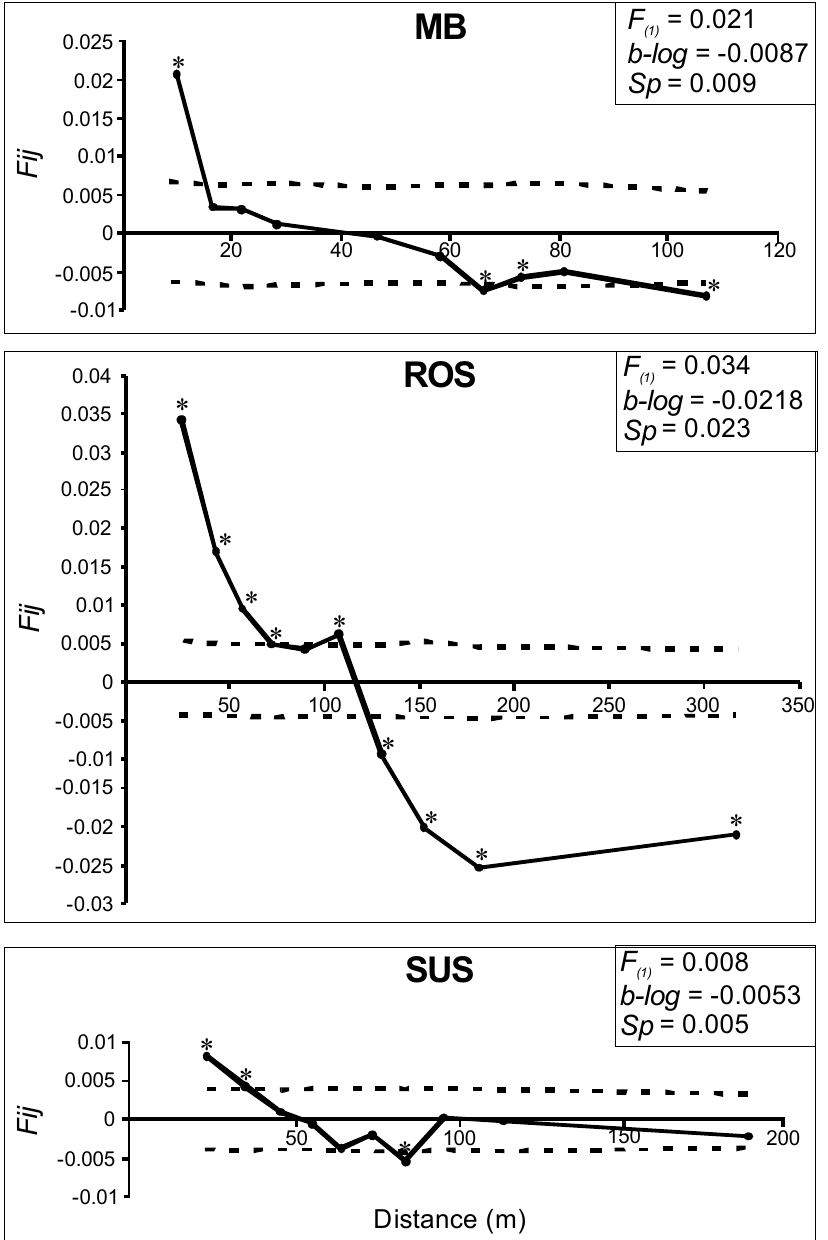
Figure 4. Spatial correlograms showing the relationship between the spatial distance and kinship coefficient of B. humilis individuals from the MB, ROS, and SUS populations. Dashed lines indicate 95% confidence intervals around the null hypothesis of randomly distributed genets. Statistically significant values are marked with an asterisk. Fij —kinship coefficient, F (1) —the average kinship coefficient of individuals belonging to the first distance class, b-log —the regression slope of observed relatedness on the logarithm of distance between individuals, and Sp —statistic describing spatial genetic structure.